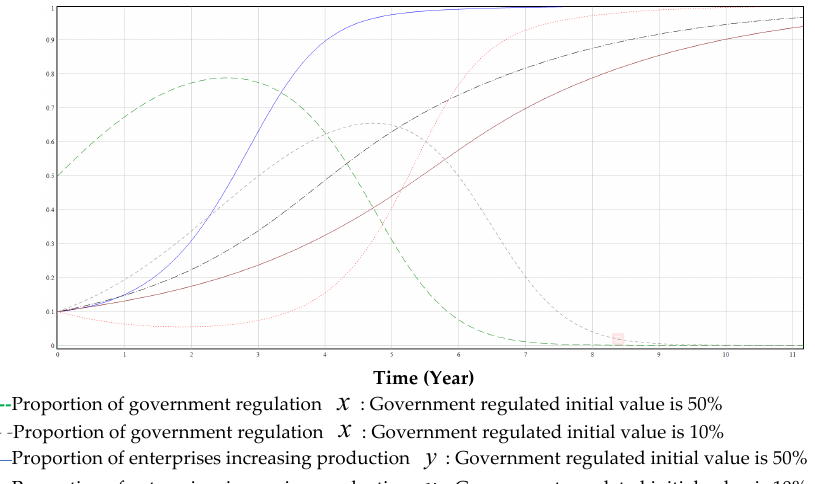
Figure 10. The impact of a high proportion of government regulation (initial value of 50% compared to 10%). Figure 11 illustrates the effect of different price increase coefficients of EFMs on de- cisions of government (a), enterprises (b), and medical institutions (c). If the price of EFMs is too high, medical institutions may not use them at all ( green dashed line in Figure 11c); if the price is too low, the enterprises’ profits will be small or even negative, thereby reduc- ing their enthusiasm for producing EFMs (blue line in Figure 11b). The high price of masks will require the government to keep regulating (green dashed line in Figure 11a). Time (Year) ( a )